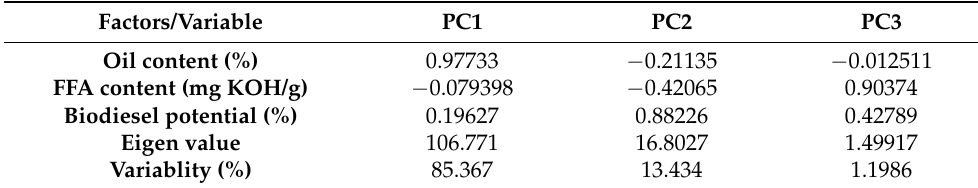
Table 3. PCA variables/factors loading for first three components.